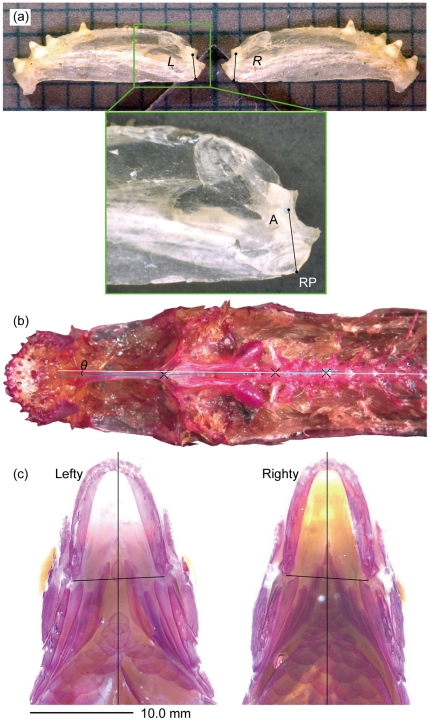
Measurement points of laterality in Exodon paradoxus for the mandible height and head inclination.Photographs of (a) the left and right mandibles and the height measurements (L and R) between the socket bottom and ventral corner of the retroarticular, (b) the head and vertebrae in the ventral views and their angle (θ), and (c) transparent specimens of lefty and righty individuals in the ventral view. Note that in (c), the lines between the right and left ventral corners of the retroarticular do not cross perpendicularly to the vertical lines that indicate the midlines of the bodies, but rather slant to the left or right in the lefty and righty, respectively.